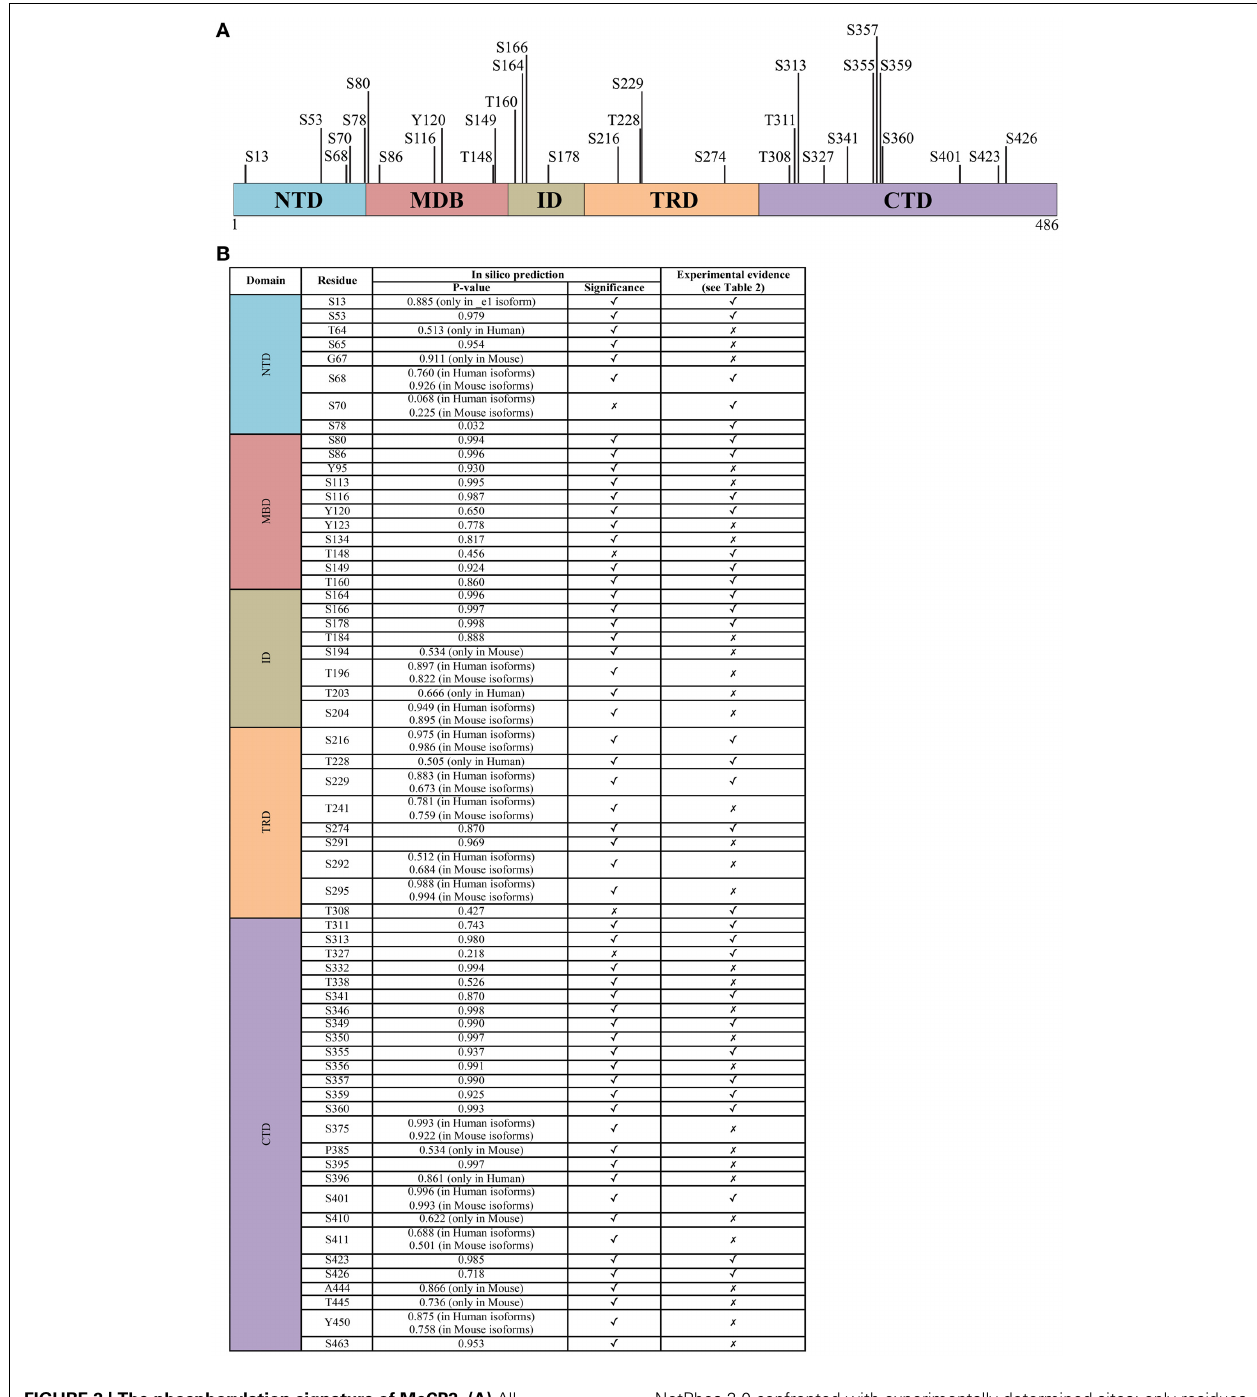
NetPhos 2.0 confronted with experimentally determined sites; only residues identified as phosphorylation sites in silico with P > 0 . 5 are listed. Further details including references of experimentally determined sites are listed in supplementary Table